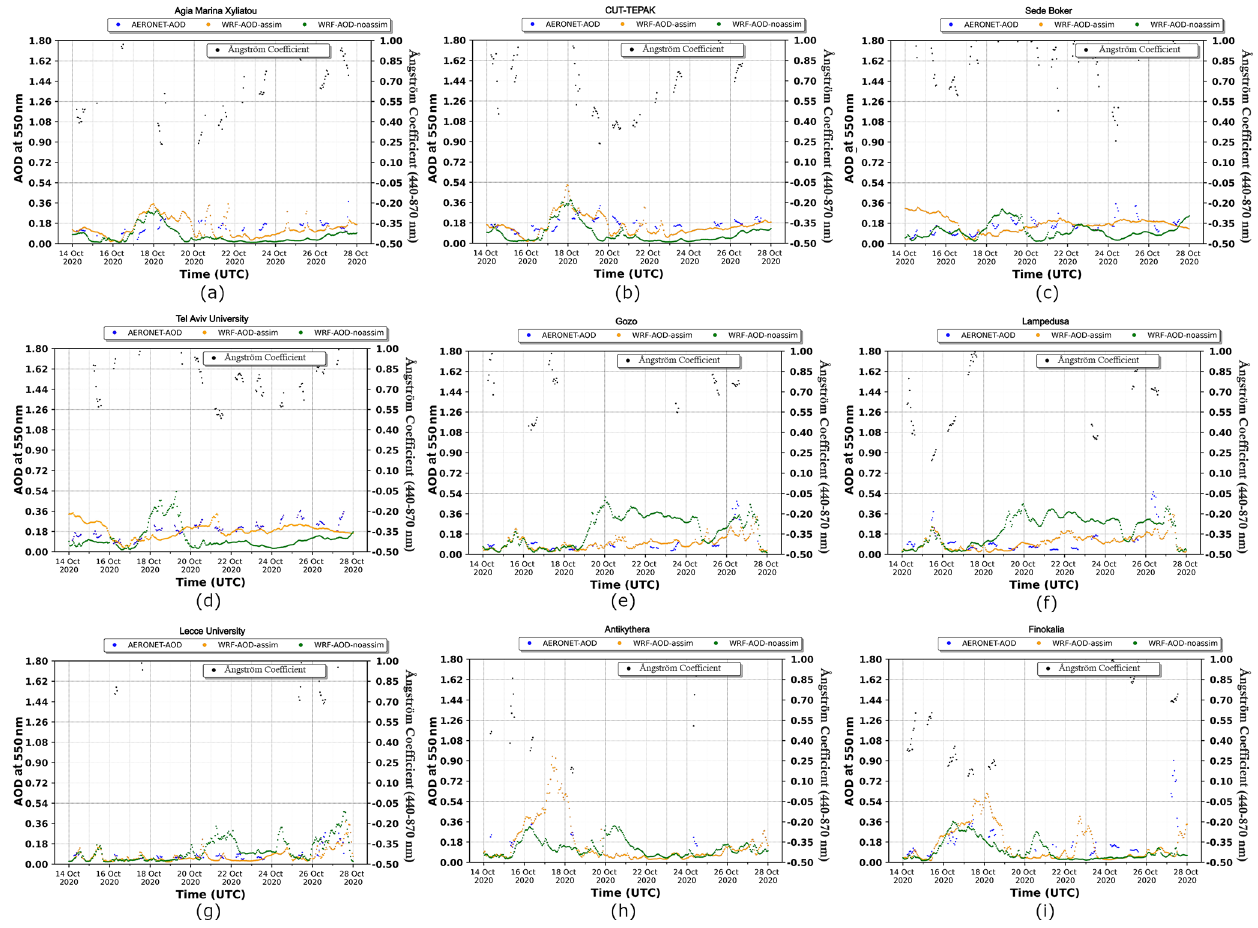
Figure 6. Time series plots of observed AOD (blue points) from AERONET stations within the model domain, contrasted against assimilated AOD (yellow) and control AOD (green). Additionally, the black points represent the Ångström coefficient obtained from the AERONET